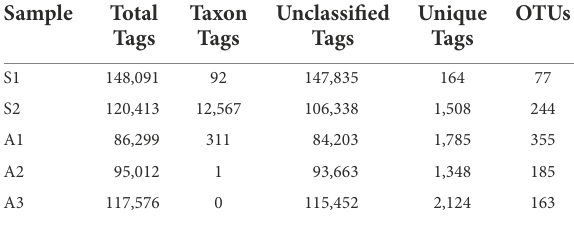
TABLE 1 Total number of tags, taxon tags, unclassified tags, unique tags, and